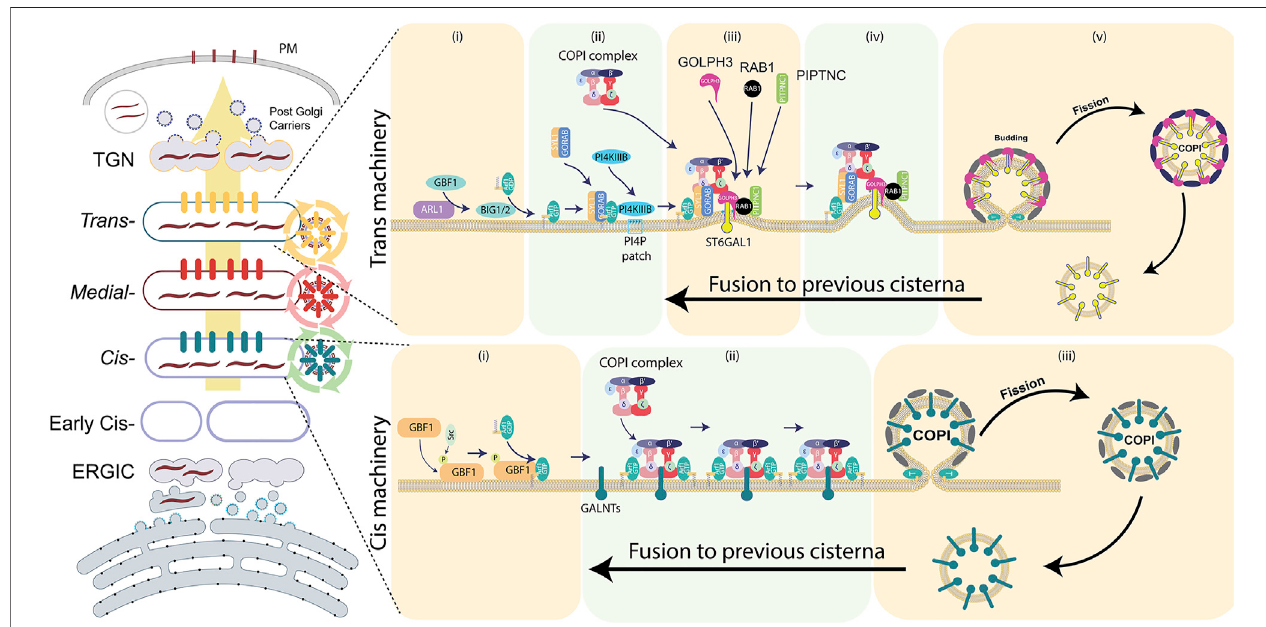
FIGURE 4 | Components of the COPI-dependent recycling machinery at the cis- and trans- Golgi faces. Several of components of CMM found to be ampli fi ed in solid tumors. For further details, refer to the main text.